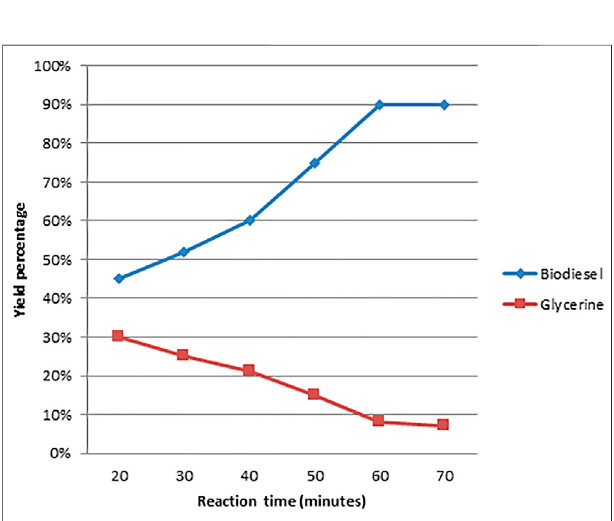
FIGURE 7 | Effect of reaction time on the production of biodiesel from